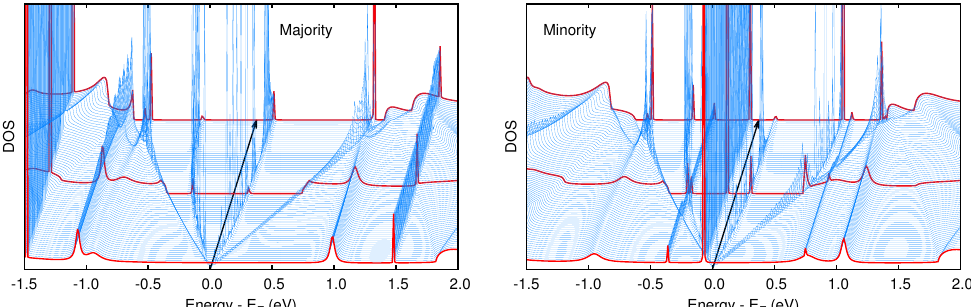
Figure 3. k || -resolved DOS for the two spin components. The red lines at Γ , X and at the mid-point of the Γ − X path are highlighted for a better reading of the plot ( Γ being in the foreground and X in the background). The black arrow represents the Fermi